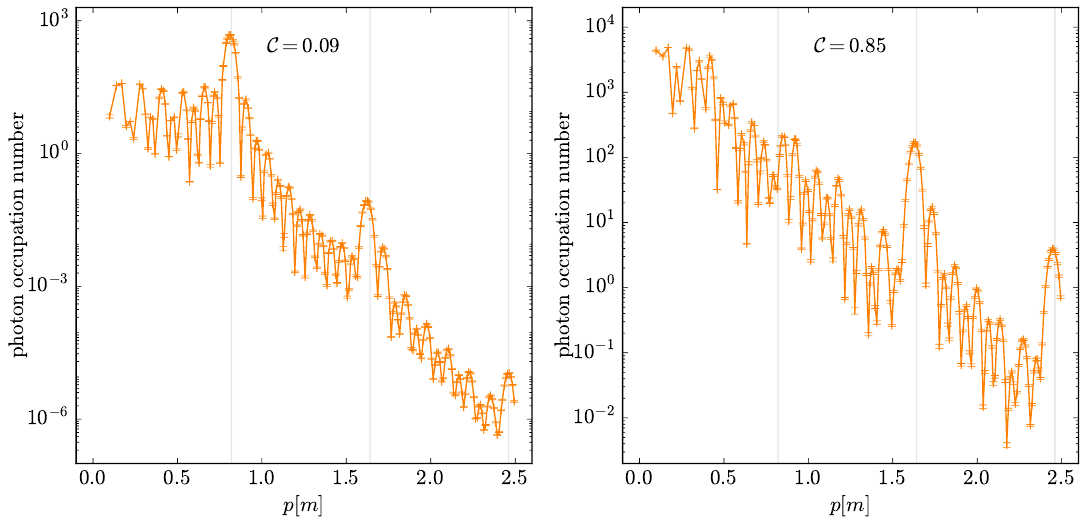
Figure 9 . The photon particle number distribution in momentum space obtained by taking a Fourier transform of the electromagnetic fields in our simulation volume at a fixed time (for more details, see [41]). Three gray lines represent p = ω , 2 ω and 3 ω . Left panel is for C = 0 . 09 whereas the right panel is for C = 0 . 85 . Note that at C = 0 . 85 , the dominant radiation frequency in ω is absent, and is connected to the suppression of power in the magnetic field background at this